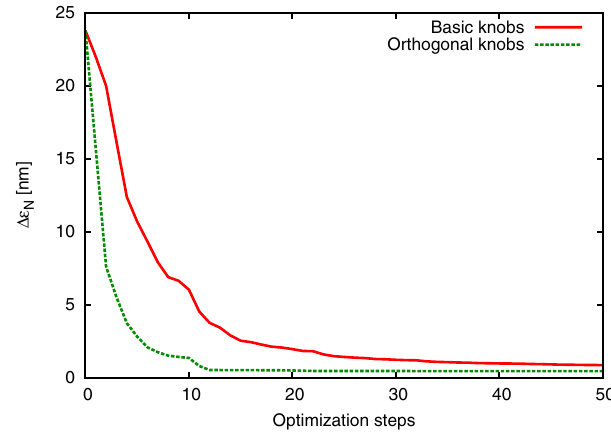
FIG. 14. Basic use of ten structures each controlled by a knob compared to using orthogonalized knobs each controlling all ten structures. In one iteration, the basic method reduces emittance growth to 6.0 nm, while orthogonal knobs reduce growth to 1.3 nm. With the new knobs, emittance growth converges rapidly to 0.44 nm, in perfect agreement with theoretical predictions obtained from the eigenvalues of (cid:1) . The convergence for the basic knobs is clearly slower with a final emittance growth of 0.87